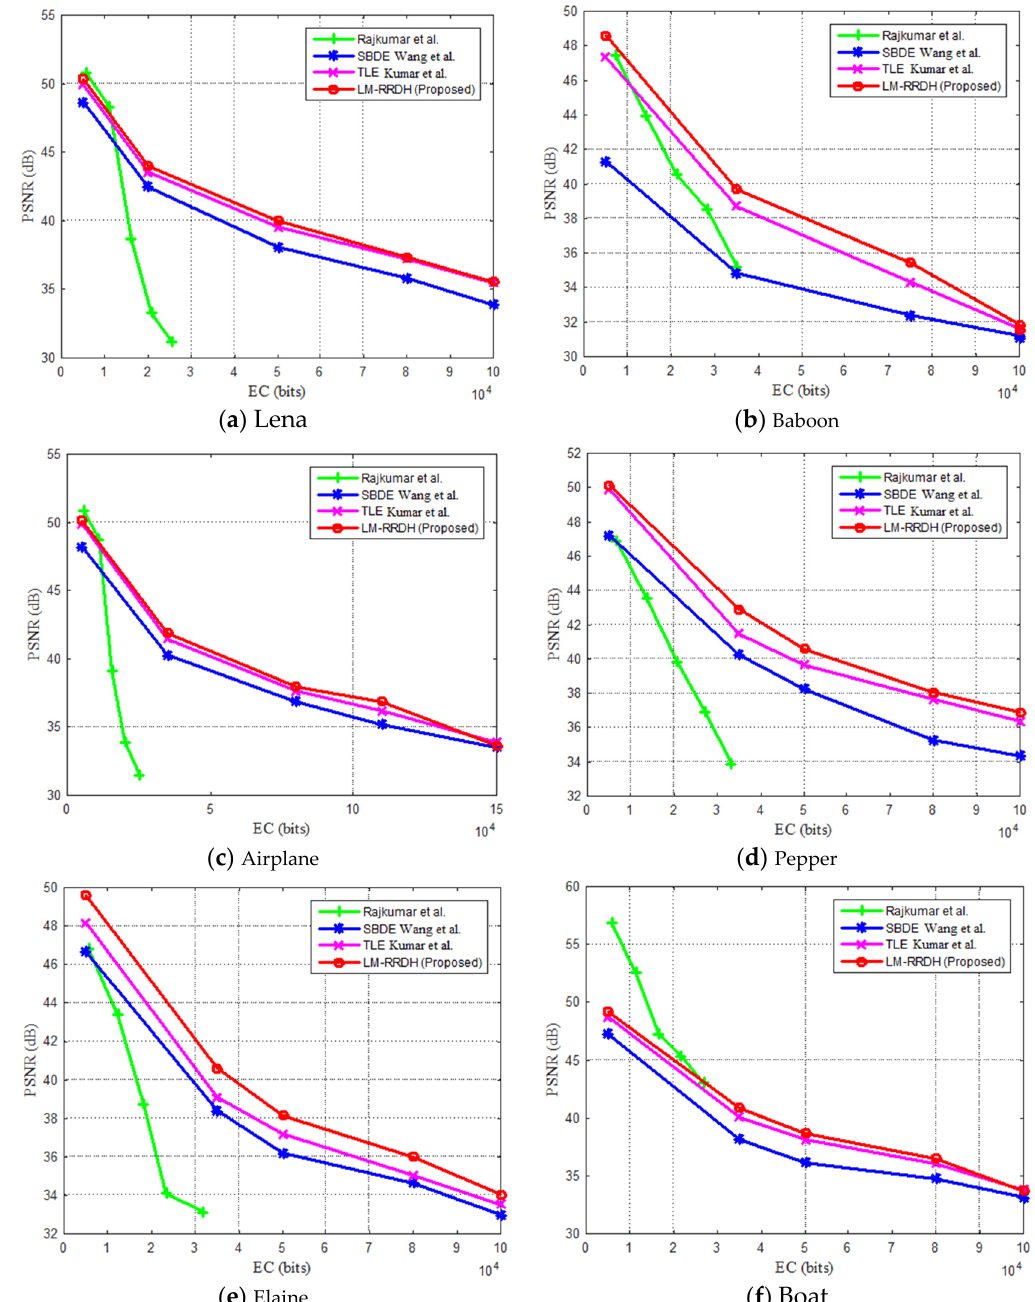
Figure 6. PSNR vs. EC evaluation for the test images [28–30].